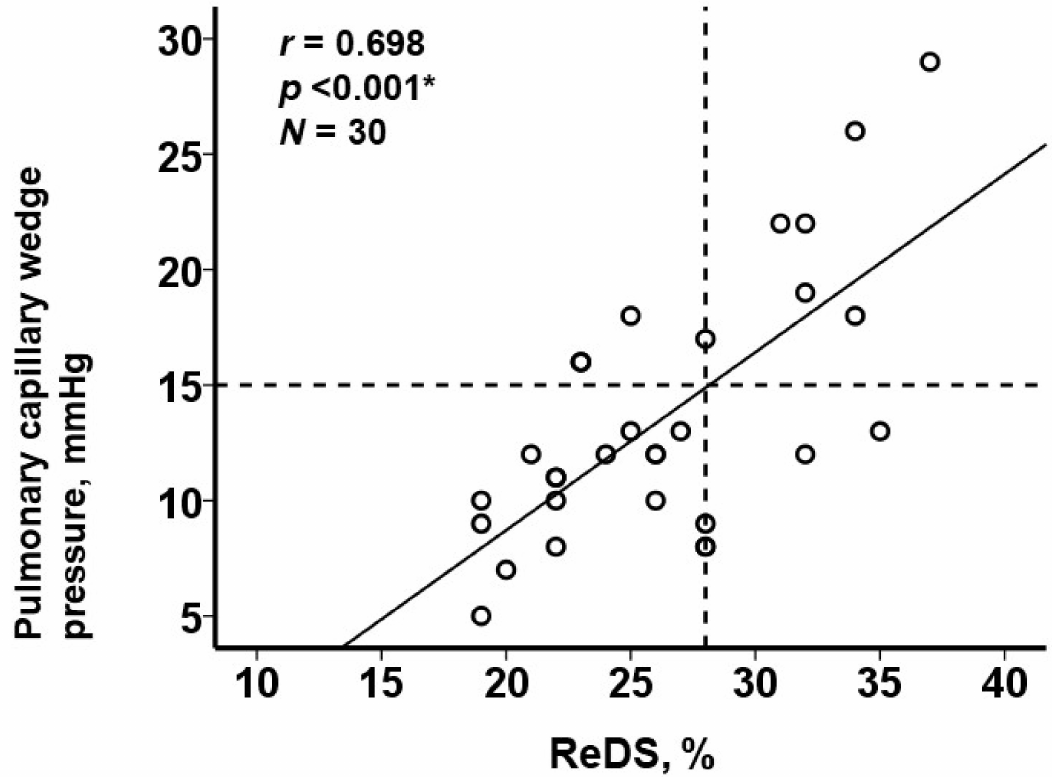
Figure 2. Relationship between ReDS values and PCWP values. A vertical line (ReDS value 28%) indicates a cutoff to predict PCWP > 15 mmHg. * p < 0.05 by Pearson’s correlation